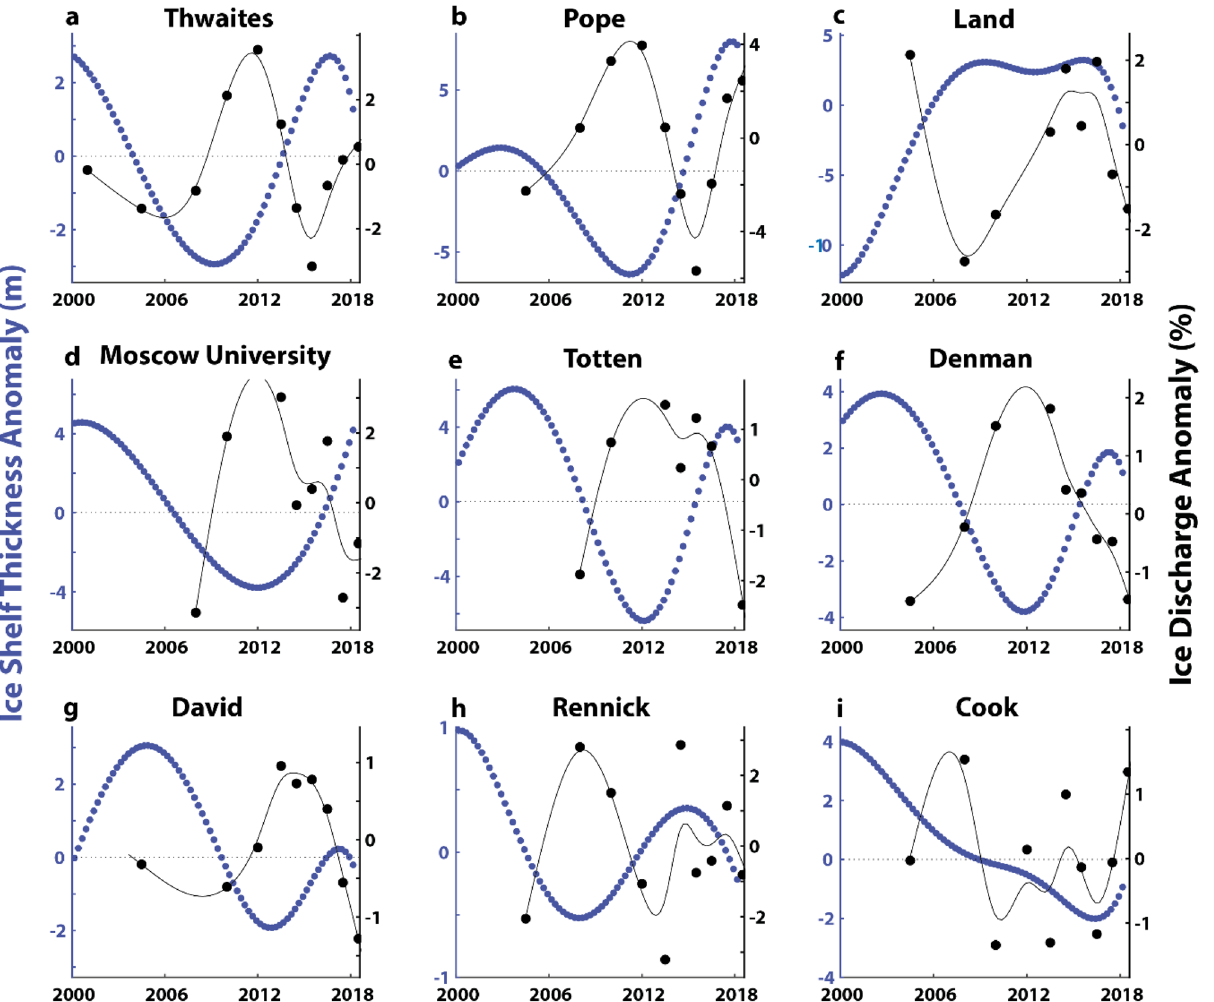
Figure 5. Linearly de-trended anomalies in ice-shelf thickness (m) versus linearly de-trended anomalies in ice discharge (%) for the ( a ) Thwaites, ( b ) Pope, ( c ) Land, ( d ) Moscow University, ( e ) Totten, ( f ) Denman, ( g ) David, ( h ) Rennick and ( i ) Cook East Glaciers. Note different scales on the y -axes and that the Cook catchment has been seperated between the East tributary and West tributray. This is because the West tributary does not have an ice shelf. The original ice-shelf thickness data has been taken from dataset produced in 16